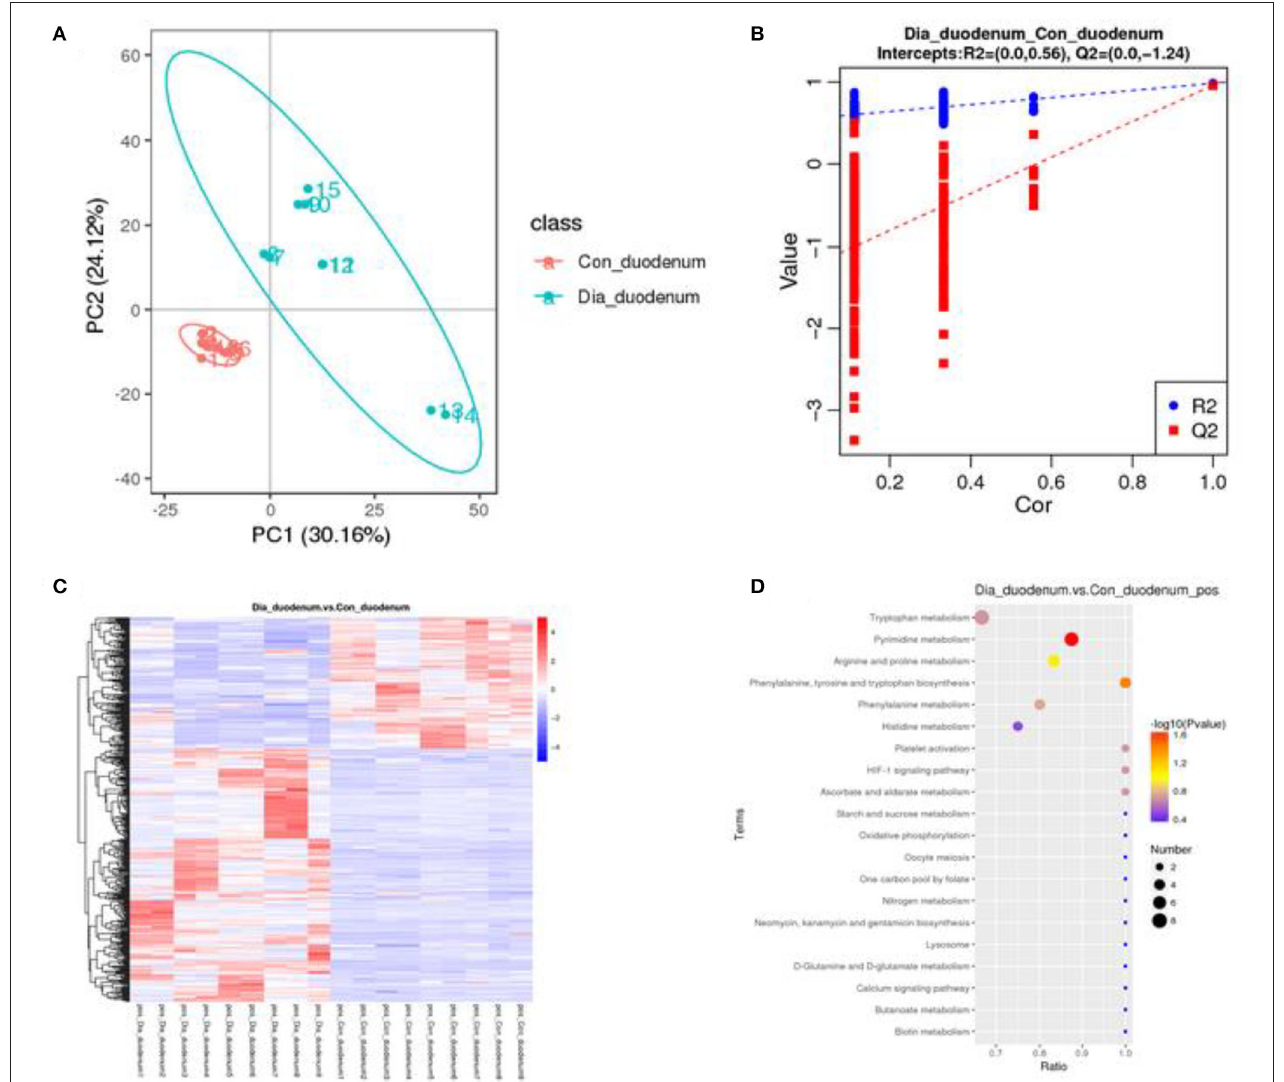
FIGURE 6 | Multivariate statistical analysis of fecal metabolites in healthy and diarrhea rabbits (A) PCA and OPLS-DA plots showing the spatial division between healthy and diarrhea rabbits (B) , heatmap and KEGG of differences in the metabolites of metabolic pathways in duodenum between the CG and the EG, which was significant (C,D)